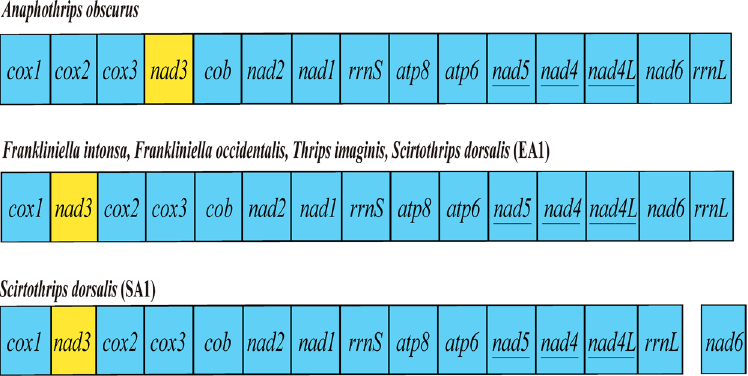
Figure 4. The arrangement of protein-coding and rRNA genes in the mitochondrial genomes of thrips. Genes are transcribed from left to right except those underlined, which are transcribed from right to left. tRNA genes are